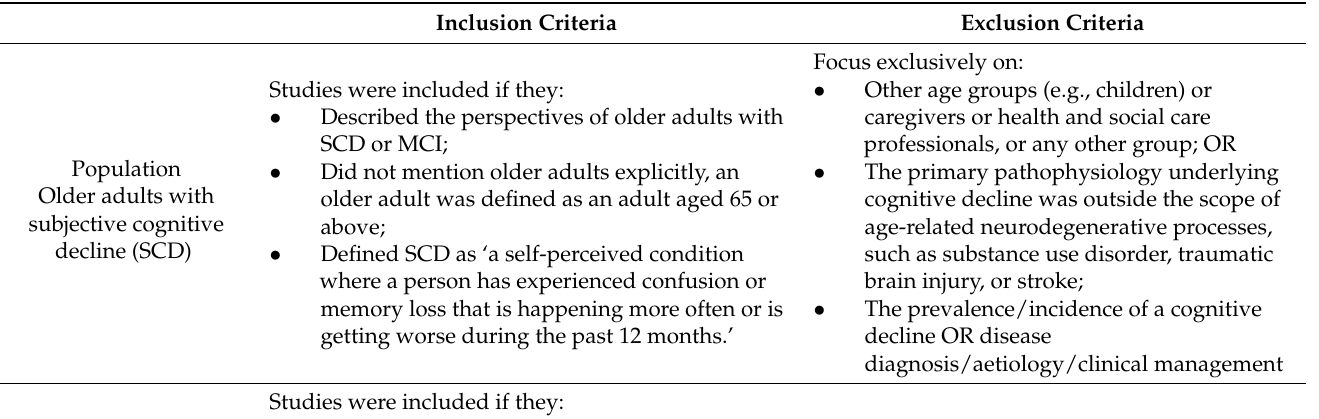
Table 2. PCC framework of inclusion and exclusion criteria used in the literature